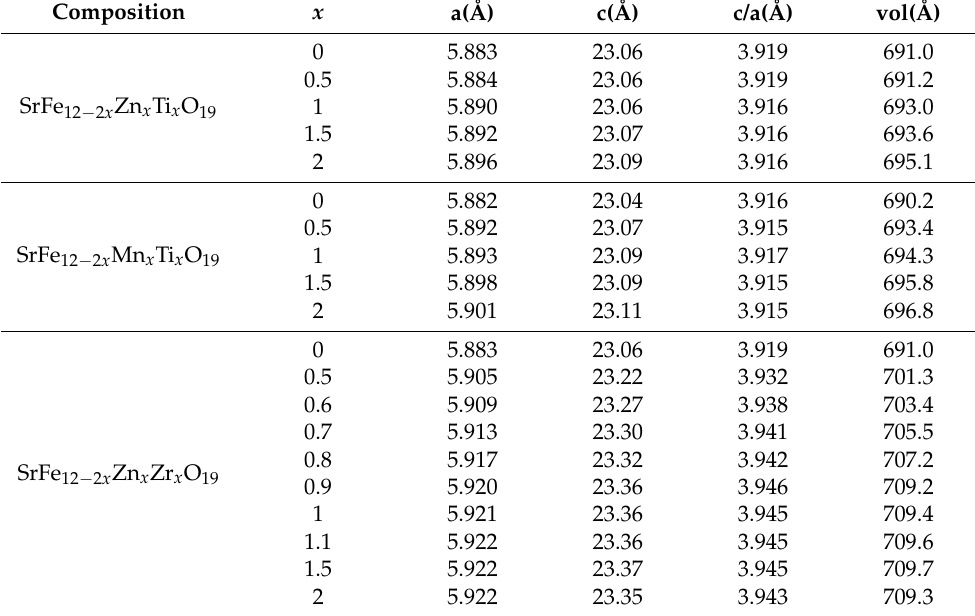
Table 1. Lattice parameters a and c , ratio of c / a , and lattice volume of the SrFe 12 − 2 x Zn x Ti x O 19